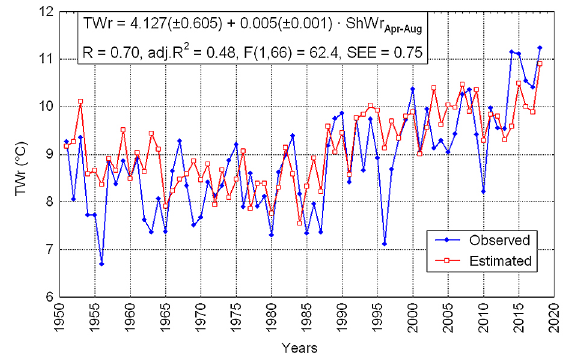
Fig. 7. The course of annual air temperature in Wrocław (TWr) and annual air temperature estimated based on long-day months of sunshine duration in Wroclaw (ShWr ). The relationship between TWr Apr–Aug and ShWr and its statistical characteristics are in Apr–Aug the upper frame of the